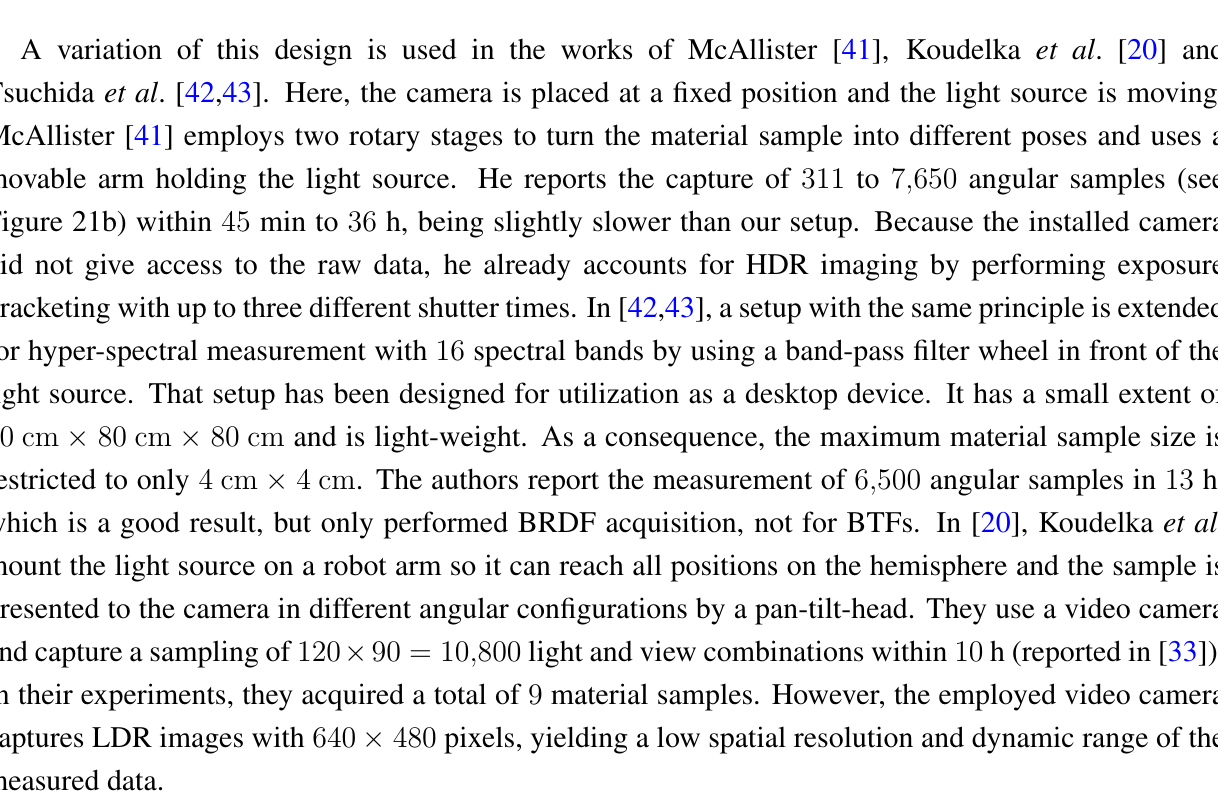
Figure 20. Sampling of the spatial domain for selected setups. Our setups are shaded in green. The size of the rectangles shows the maximum spatial extent of the sampling area. The raster inside the rectangles corresponds to the sampling density with a factor of 1 : 100 on both axes. For [46], [18] and [5], two configurations are shown. Please refer to Table 6